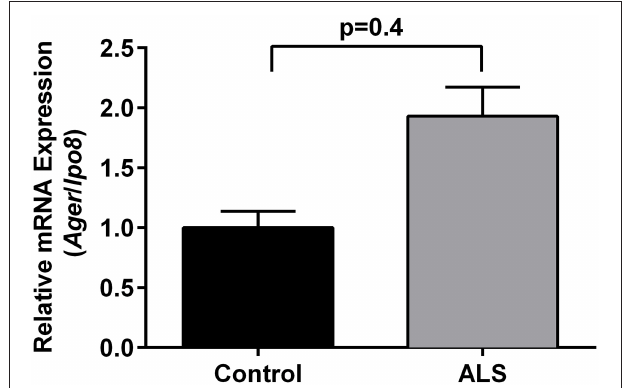
lumbar spinal cord: mRNA transcripts. Relative mRNA expression of Ager mRNA transcripts was determined by quantitative RT-PCR normalized to Ipo8 mRNA transcripts ( n = 3 mice/group). Error bars represent